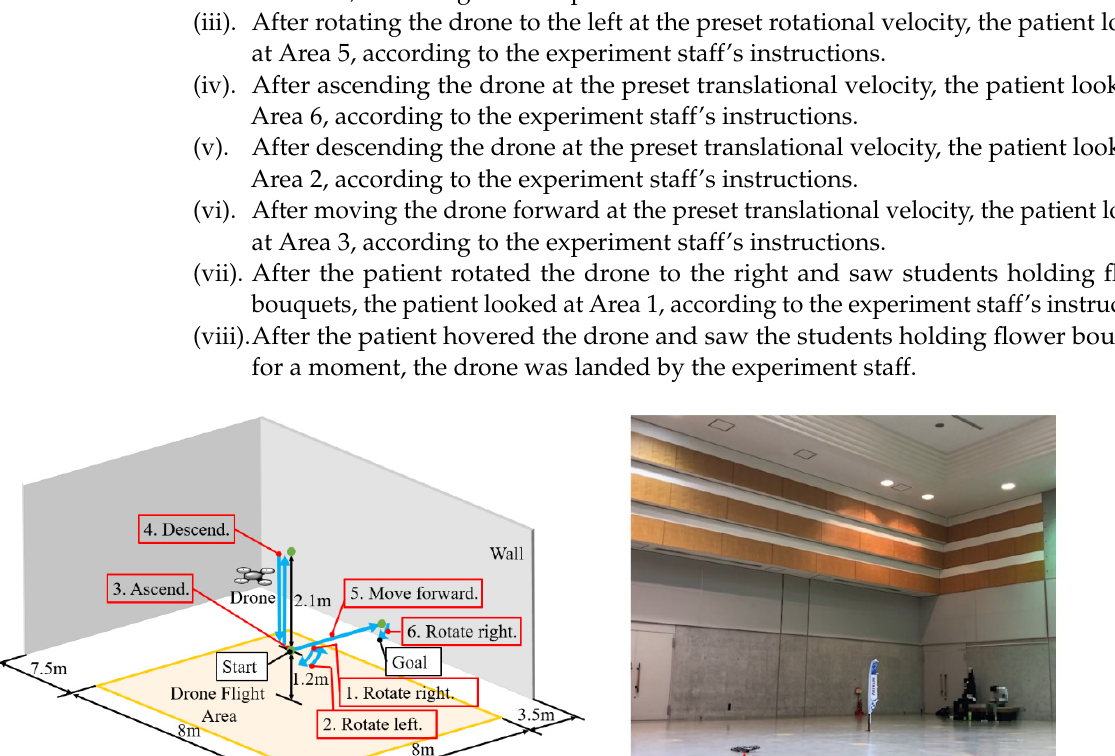
gymnasium at Tokai